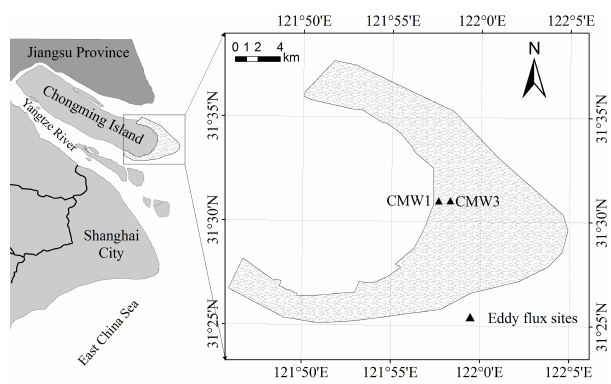
Fig. 1. Location of research